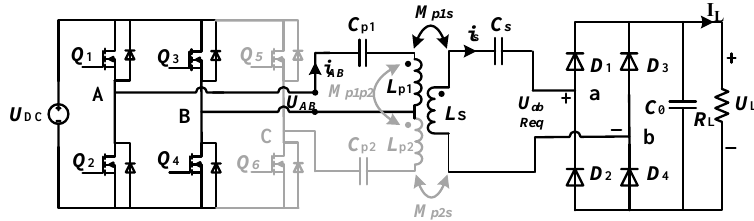
Figure 5. The symbols “ ’ ” means that the equivalence was measured from the secondary side to the primary side. L kp1 and L ’ ks means the leakage-inductance of the primary and secondary coil, respectively, and L m1 represents the magnetizing inductance. L kp1 and C p1 are equivalent to capacitor C eq1 . C ’ S shows the equivalent capacitance of the secondary side compensation capacitance converted to the primary side. R ’ eq indicates that the equivalent resistance was converted from the secondary side to the primary side. Z Rcc , Z m1 , and Z incc represent the impedance.